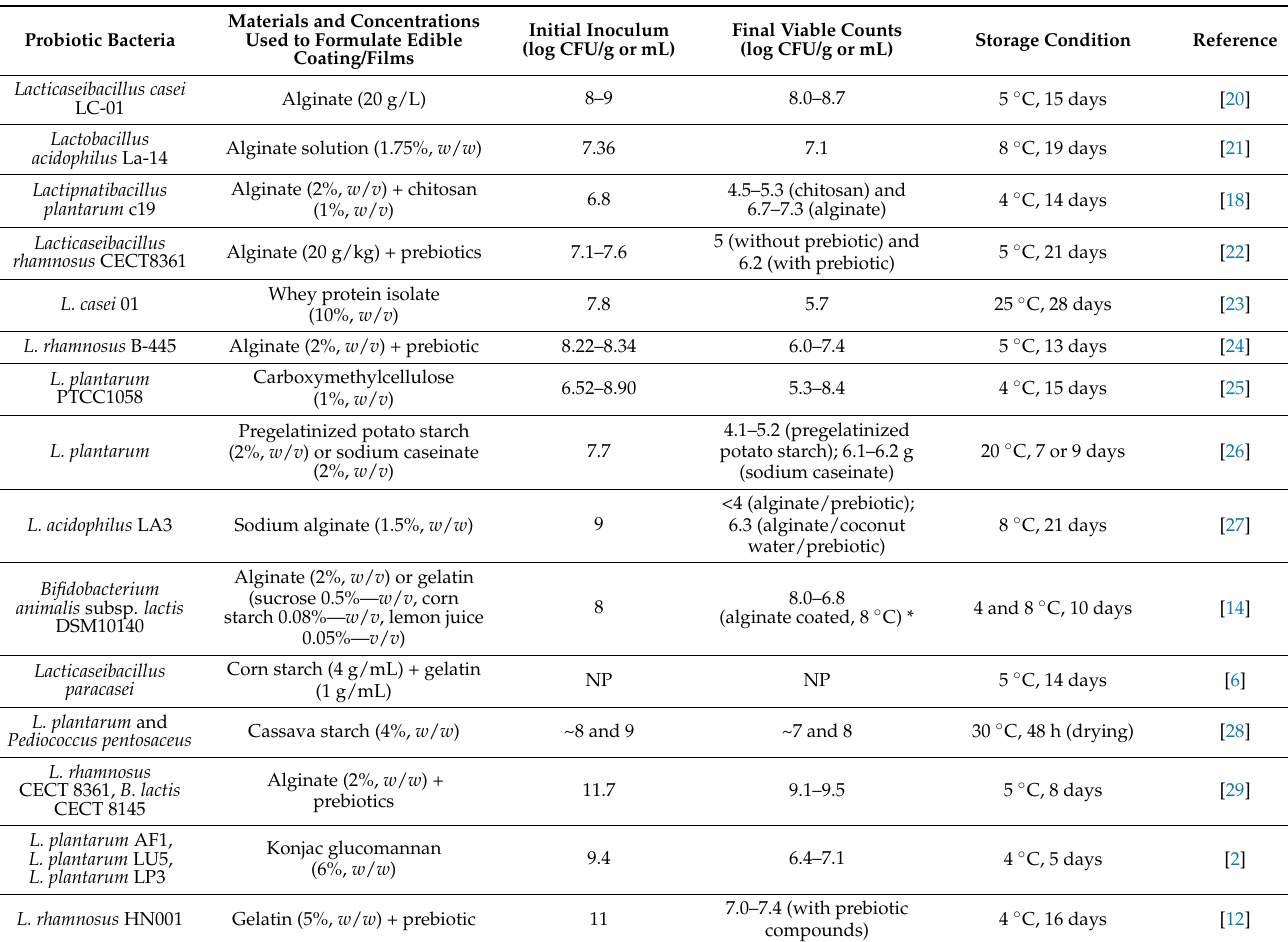
Table 2. Viable counts (survival) of probiotics loaded into edible films/coatings applied to fruit and vegetables. Materials and Concentrations Probiotic Bacteria Used to Formulate